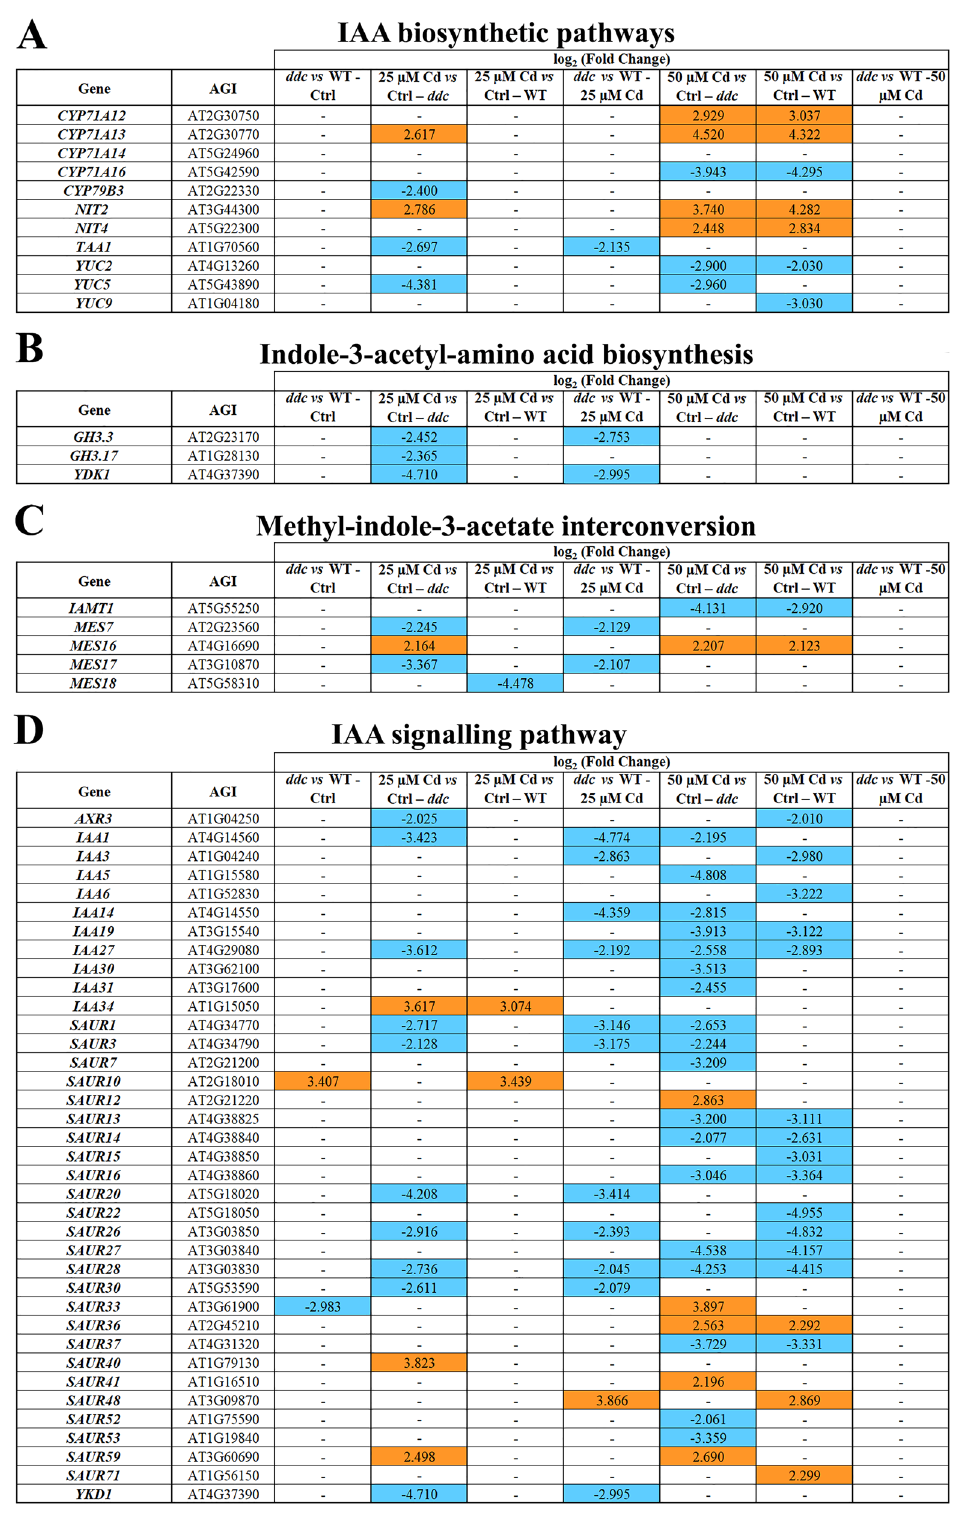
Figure 2. Genes differentially expressed (DEGs) along the pathway of ( A ) auxin biosynthesis, auxin conjugation, ( B ) indole-3-acetyl-amino acid biosynthesis, ( C ) methyl-indole-3-acetate interconversion and ( D ) auxin signalling in ddc and WT plants identified through a transcriptomic approach. For each comparison, the log 2 (fold change) of the analysed DEGs was shown in orange and in blue for the upregulated and downregulated genes, respectively. Plants were grown for 21 DAG in long day condition: (i) on growth medium added with 25 or 50 µM Cd; (ii) on growth medium without Cd as control